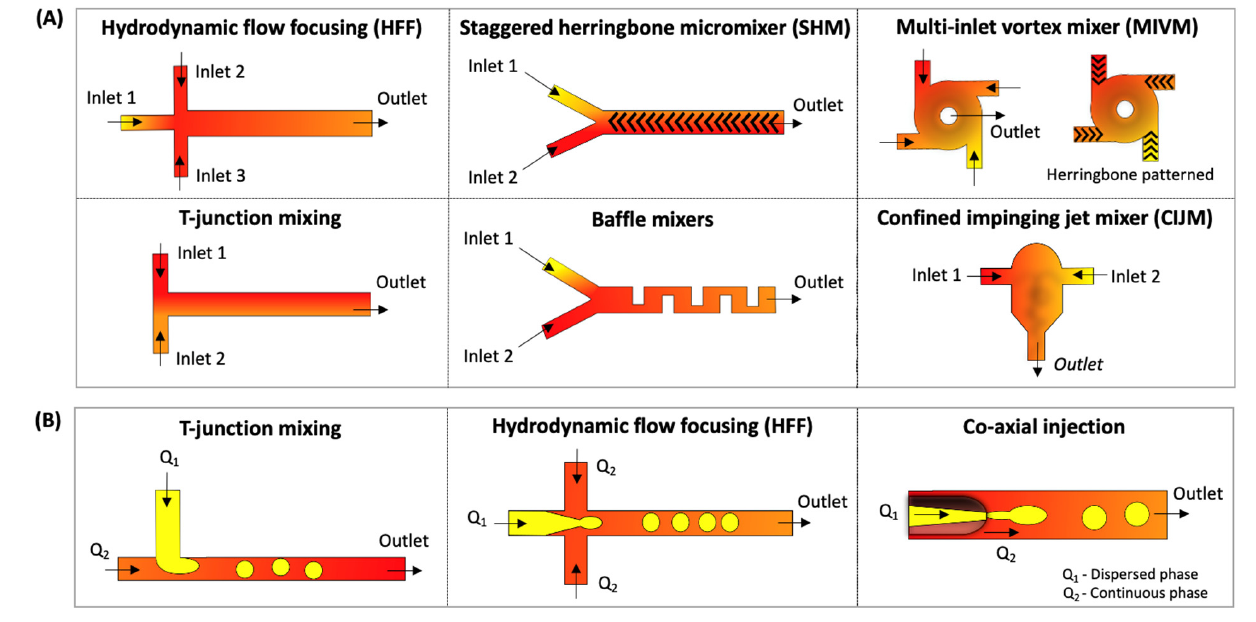
Figure 3. ( A ) Microfluidic techniques for drug and gene delivery nanoparticle formulation (liposome, lipid nanoparticles, and core/shell nanostructures). ( B ) Droplet-based microfluidics for lipid-based nanostructure encapsulation and artificial lipid cell synthesis.